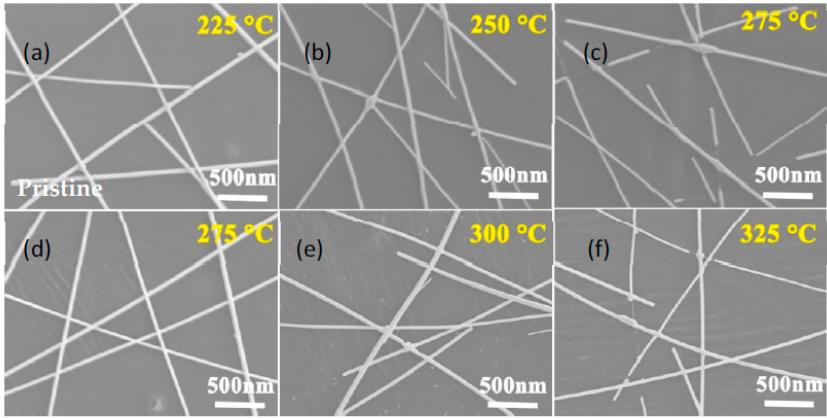
Figure 6. SEM images of pristine and 60 min FeCl 3 -DS treated AgNW TCFs of 50 nm-thick AgNWs under different thermal test temperatures: ( a ) 225 °C, ( b ) 250 °C, and ( c ) 275 °C for pristine AgNWs; ( d ) 275 °C, ( e ) 300 °C, and ( f ) 325 °C for 60 min FeCl 3 -DS treated AgNWs.